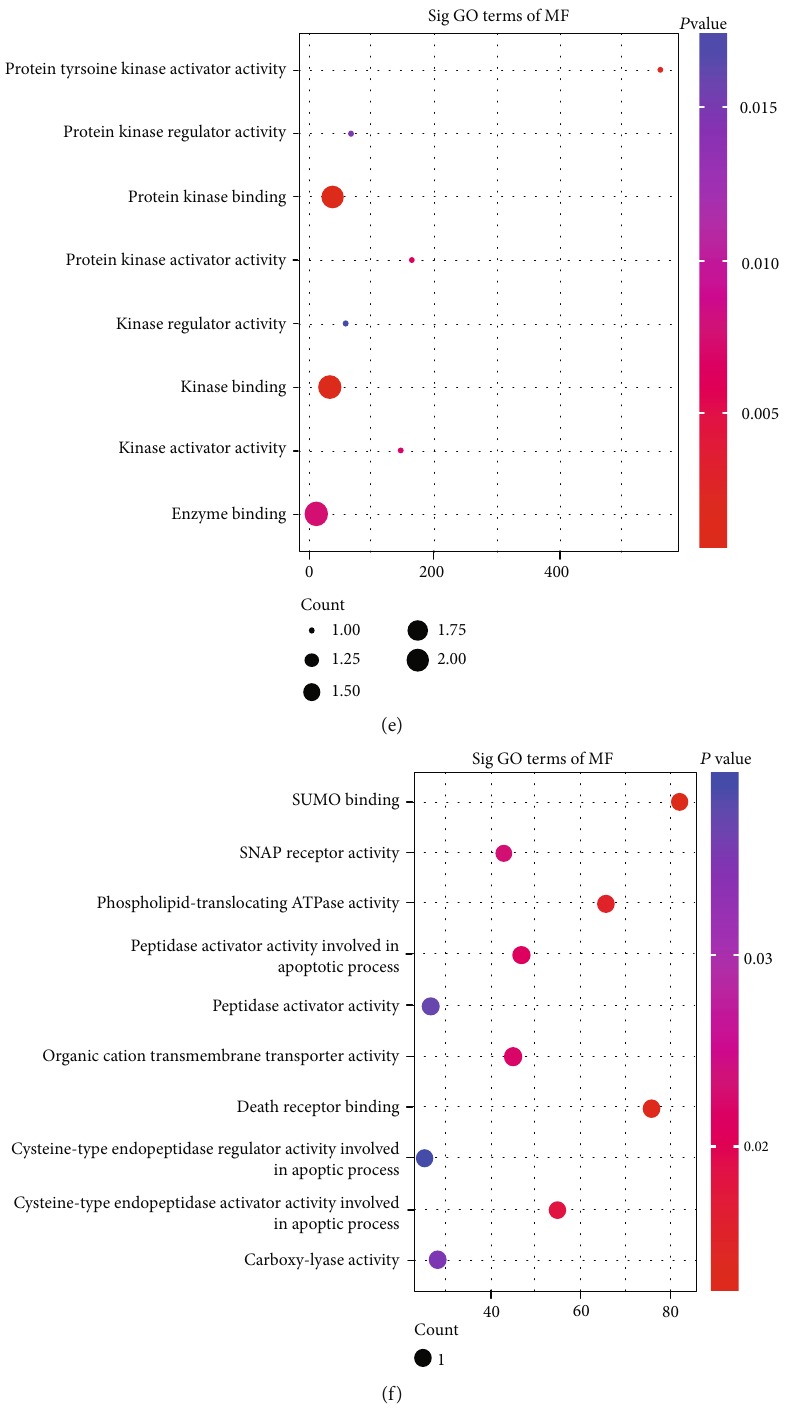
Figure 2: The top predicted functional terms of source genes regulated by di ff erentially expressed lncRNAs in GD were obtained with GO analysis. They were categorized based on biological process (BP), cellular component (CC), and molecular function (MF). (a) The top GO terms of upregulated lncRNAs in BP. (b) The top GO terms of downregulated lncRNAs in BP. (c) The top GO terms of upregulated lncRNAs in CC. (d) The top GO terms of downregulated lncRNAs in CC. (e) The top GO terms of upregulated lncRNAs in MF. (f) The top GO terms of downregulated lncRNAs in